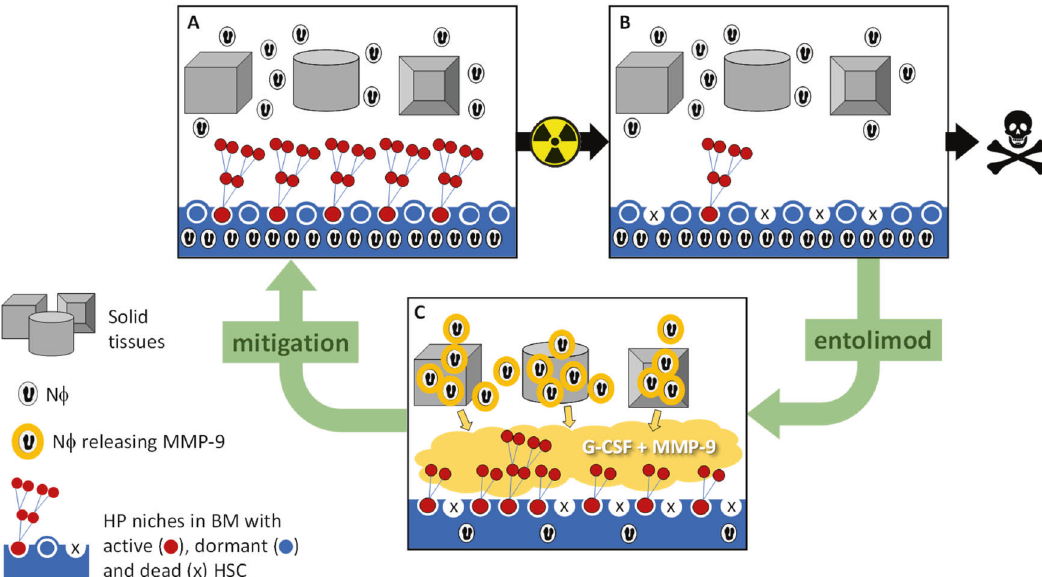
Fig. 6 Proposed mechanism by which entolimod mitigates lethal ARS to hematopoiesis. Following lethal radiation damage, entolimod stimulates N ϕ to release MMP-9 which, in cooperation with G-CSF, accelerates the recovery of